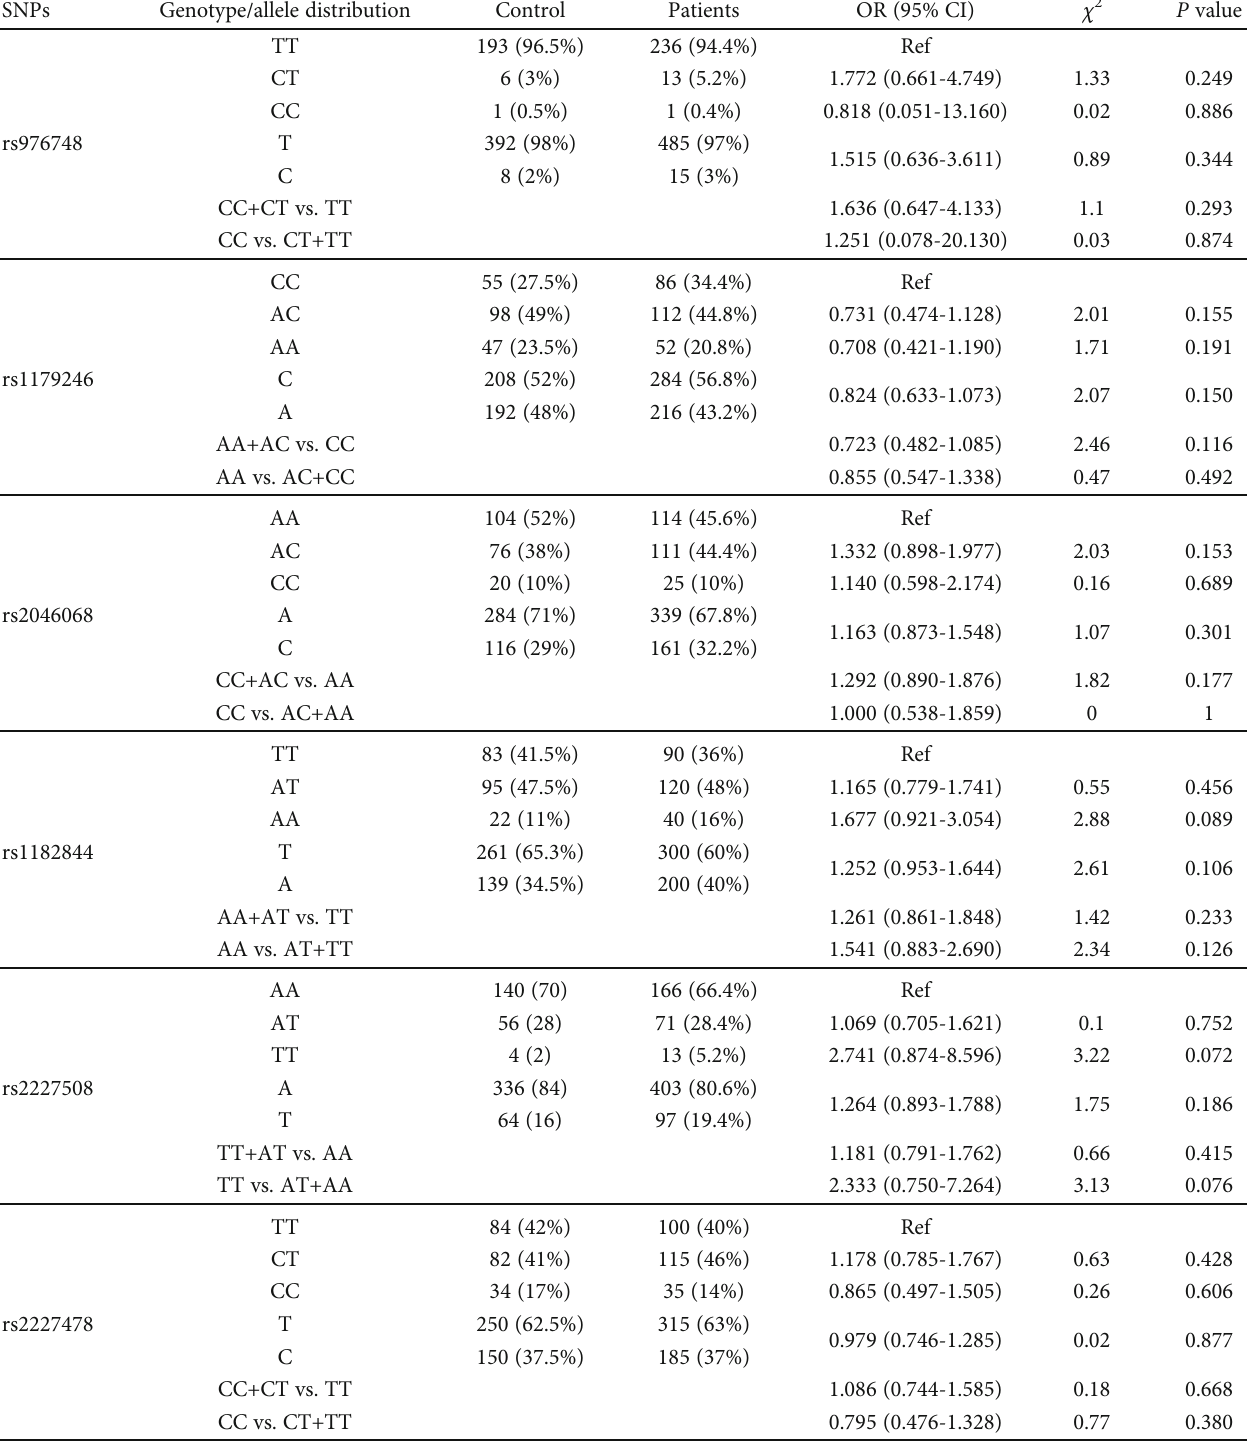
Table 1: Genotype distribution and allele frequency of IL-22 SNPs among malaria patients compared to healthy control subjects.